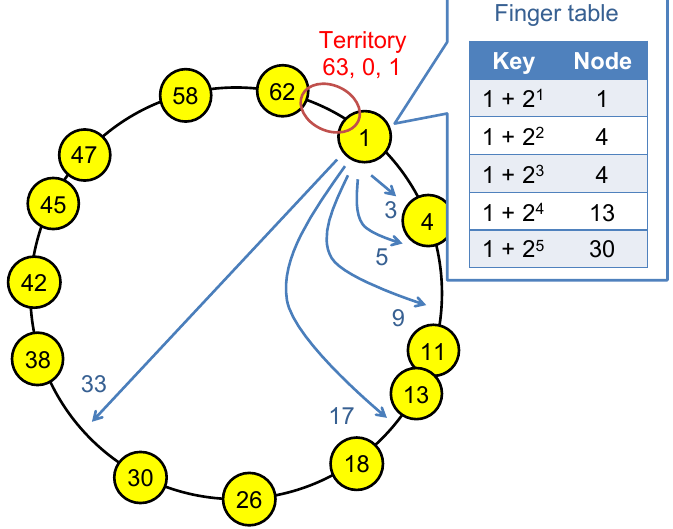
Figure 2. An example of the constructed shortcut links in